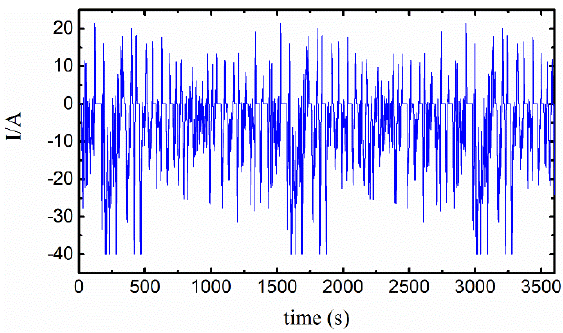
Figure 5. Off ‐ line identification results of two parameters. ( a ) Ohmic Resistances R 0 ; ( b ) Time constant τ .